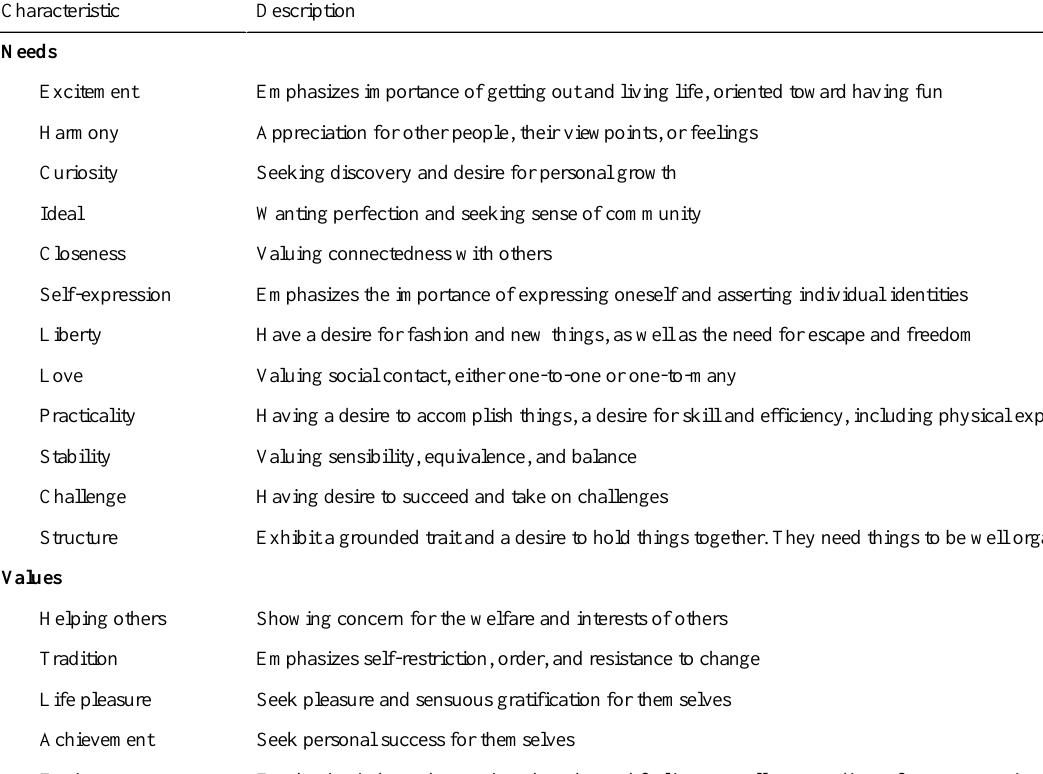
Table 1. Definitions of personal needs and values outputs.